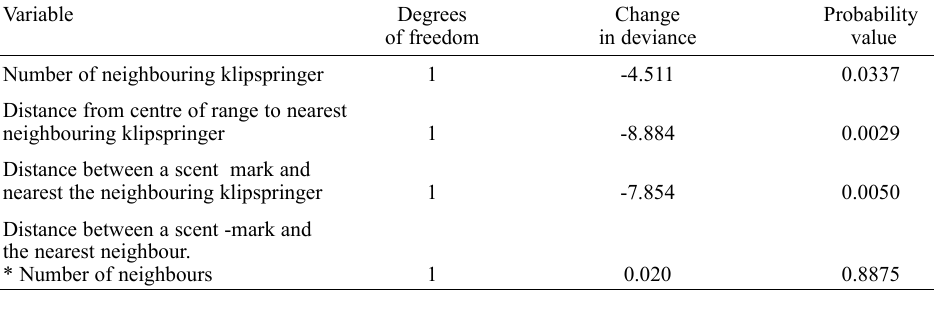
Table 1 Poisson regression analyses of the effect of neighbouring klipspringer and the distance of scent marks from the centre of the range on the number of scent marks in klipspringer in the Kruger National Park. Star notation in the table represents the interaction between 2 variables Variable Degrees Change Number of neighbouring klipspringer